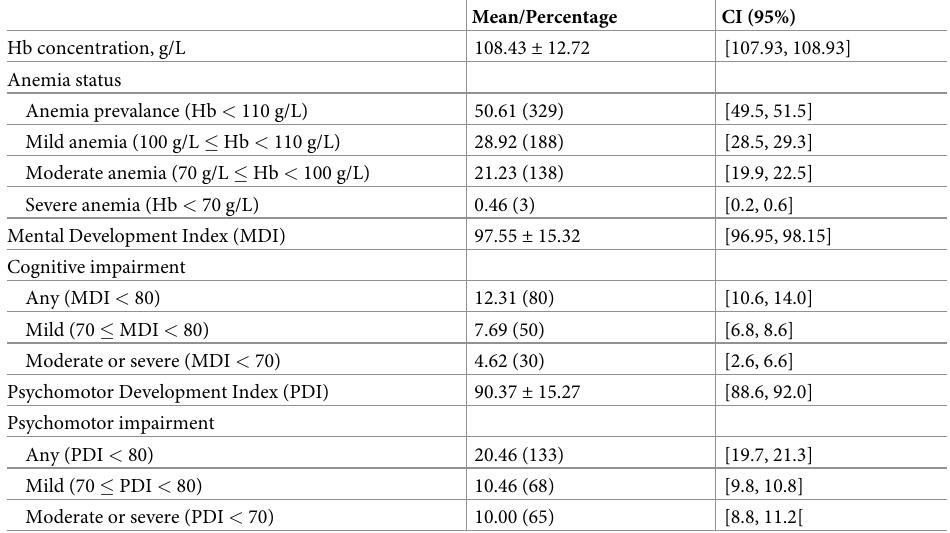
Table 2. Hb concentration, cognitive and psychomotor development of sample infants (N = 650).